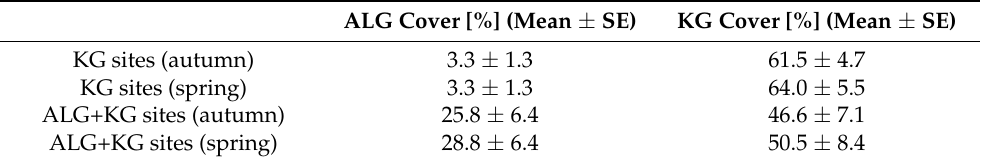
Table 1. Mean ALG and KG cover per plot for both site types